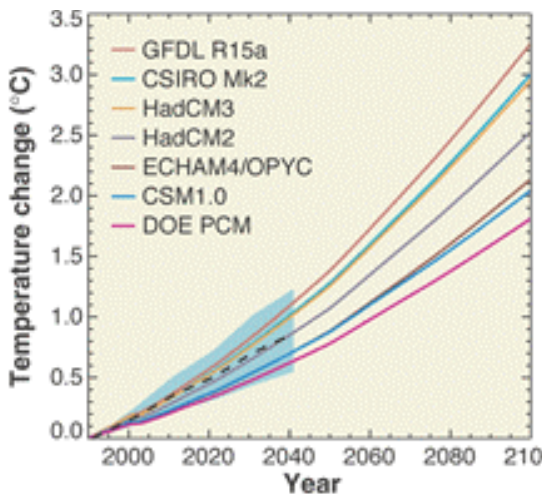
FIGURE 22. Predictions of warming in the 21 st century by six models. Note these differ primarily due to their differing climate feedback “sensitivity”. (From Allen et al. (2001) Science , 293 , 430. With